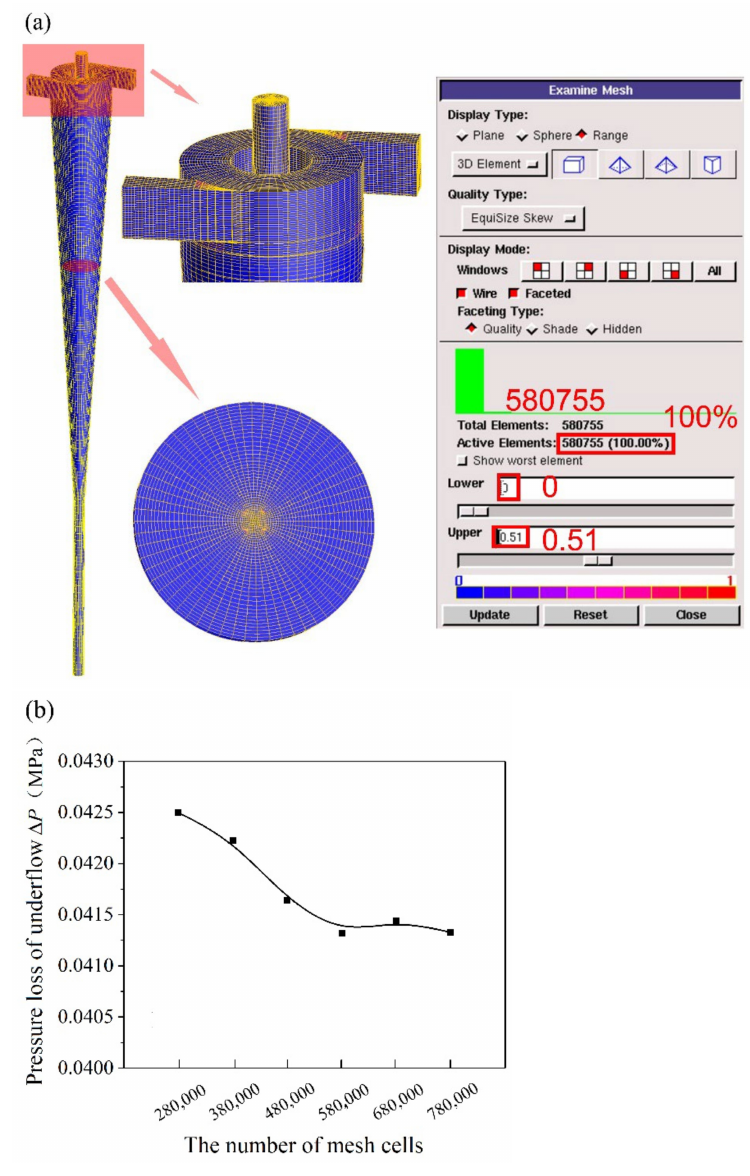
Figure 4. Meshing results and independence test. ( a ) Meshing results; ( b ) Independence test for the number of